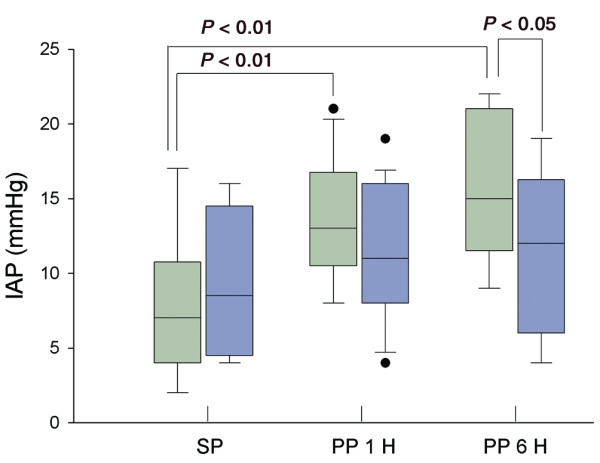
Effects of both supports on intra-abdominal pressure (IAP). The different durations of study are reported along the X-axis: SP, PP 1 H and PP 6 H represent baseline in supine position, prone position at 1 hour and prone position at 6 hours, respectively. Pale gray boxes, foam mattress; dark gray boxes, air-cushion mattress. Each box plot represents the median, the 25th and 75th centiles, and the largest and smallest values that are not outliers. Outliers are represented as filled circles. P < 0.01 and P < 0.05 by Tukey's post-hoc test.